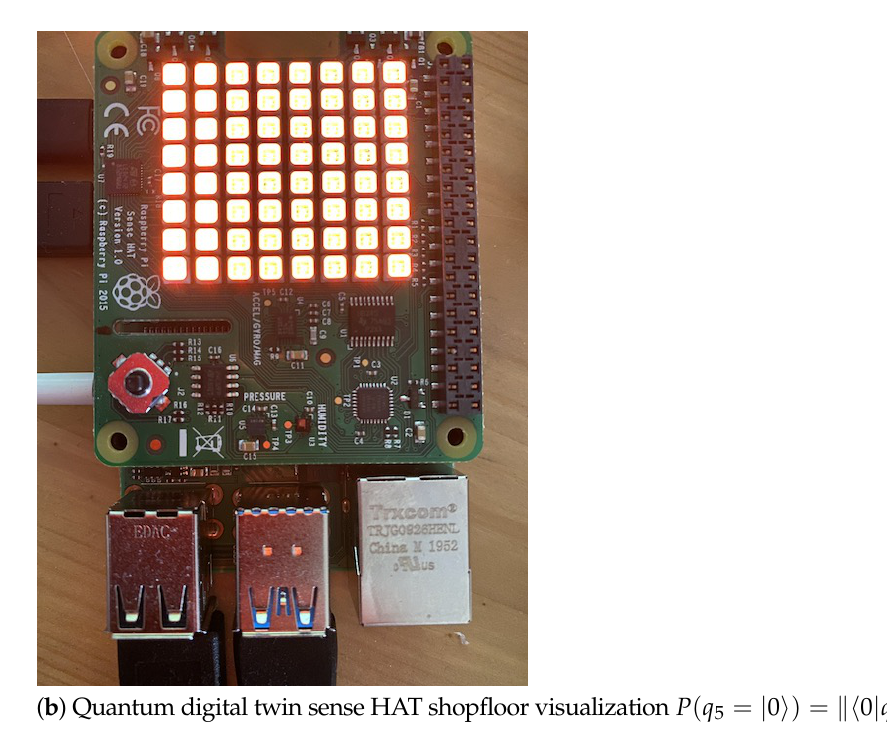
Figure 5. Quantum digital twin state probabilities and shopfloor visualization.